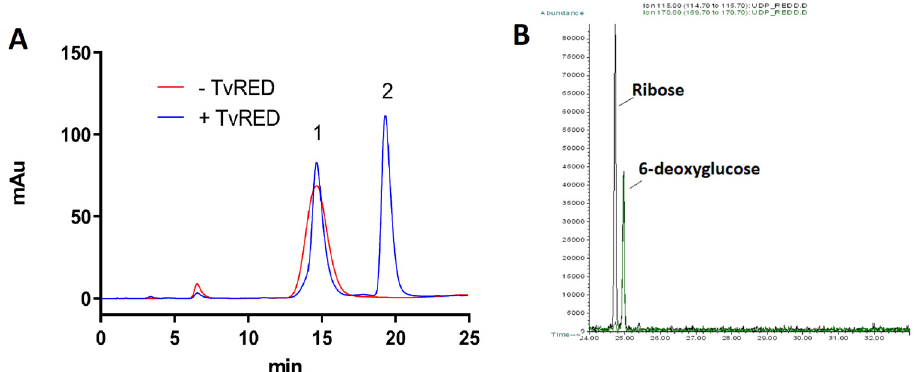
Figure 3. Analysis of TvRED products. ( A ) Anion-exchange HPLC analysis. UDP-4-keto-6-deoxy-D-Glc (red chromatogram) was produced using TvUGD and incubated with TvRED in the presence of NADPH (blue chromatogram). A change in the substrate peak shape (peak 1, red line: UDP-4-keto-6-deoxy- D -glucose; blue line: UDP-6-deoxy- D -glucose) with parallel NADP + formation (peak 2, blue line) was observed, suggestive of a reductase reaction. In this chromatographic condition, NADPH was retained in the column. ( B ) Alditol acetate GC-MS analysis TvRED product. The reaction product was isolated, subjected to acid hydrolysis, and converted to alditol acetates. The chromatograms were obtained by the extraction of m/z 115 (black line) and m/z 170 (green line) ion currents; for clarity, the chromatogram between 24 and 33 min is displayed. The analysis revealed the presence of ribose, derived from the UDP moiety, and 6-deoxyglucose. The identification of the monosaccharides was achieved by a comparison with the retention times of sugar standards and an analysis of the fragmentation spectra.